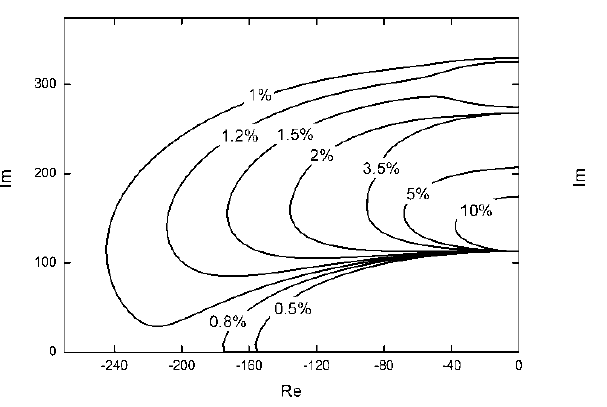
/k . ( a ) the first mode; ( b ) the second mode; ( c ) the third c c